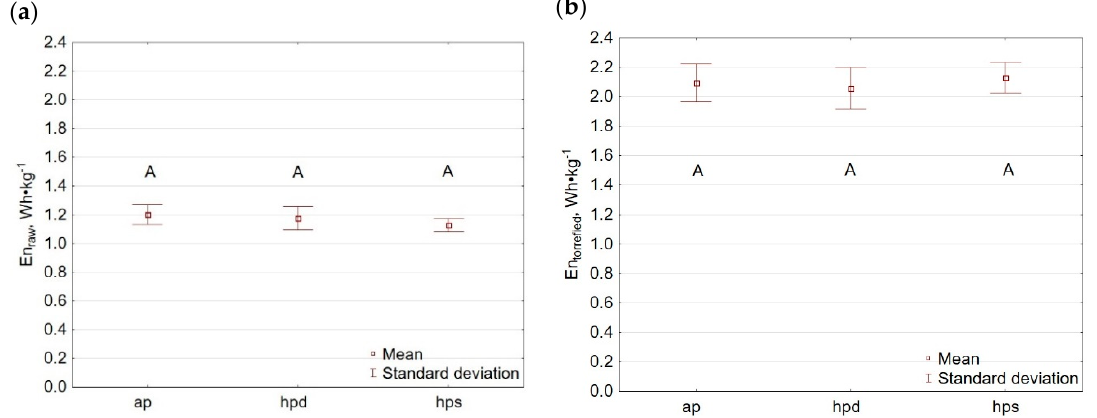
Figure 10. Energy demand to torrefied pellet production, ( a ) energy used to convert 1 kg of the pellet, ( b ) energy needed to produce 1 kg of the torrefied pellet. ( b ) energy needed to produce 1 kg of the torrefied